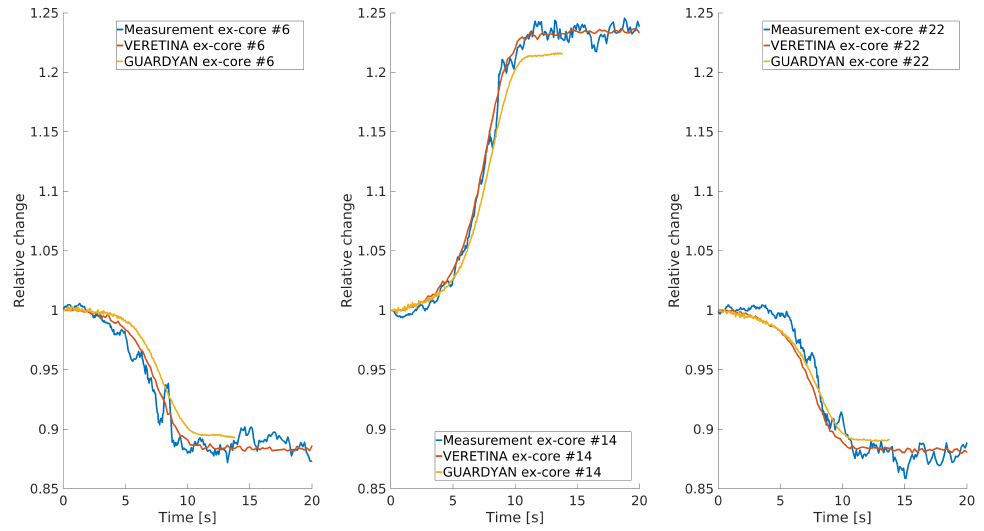
Figure 11. Relative detector